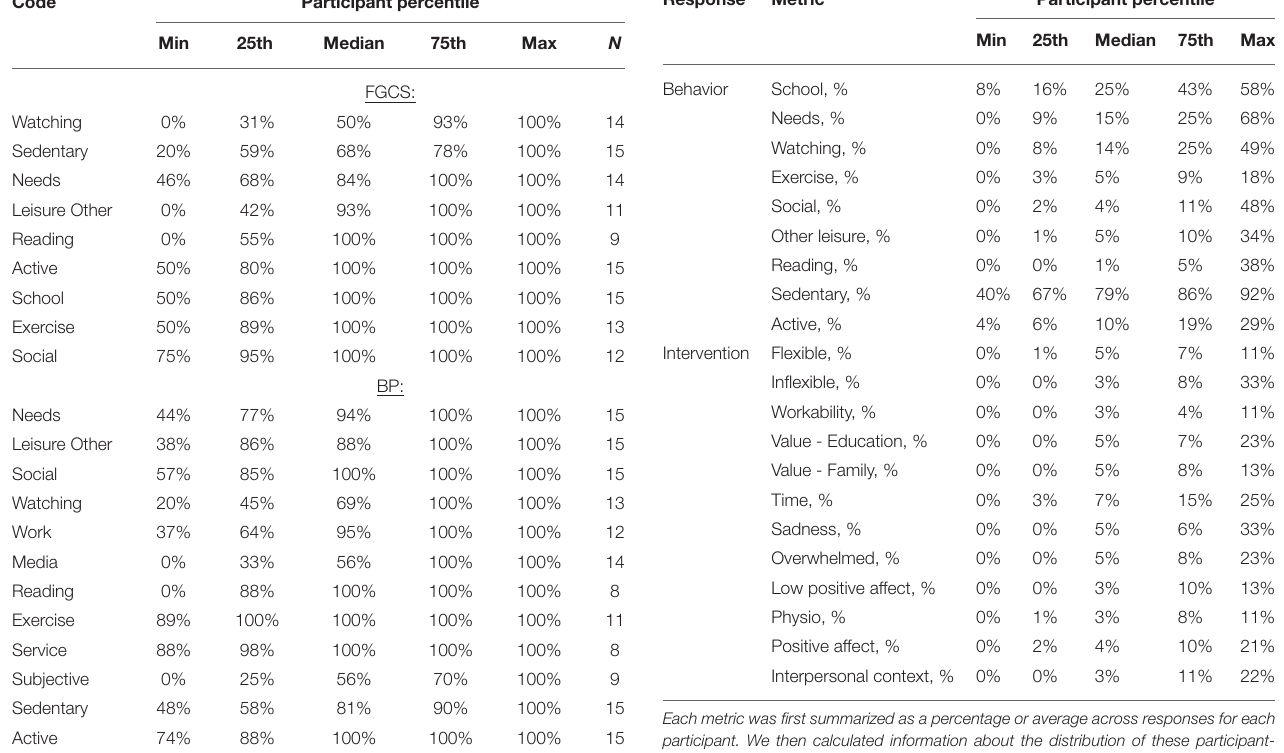
TABLE 3 | Among different behaviors, distribution of percent responses categorized as value-based across participants. Code